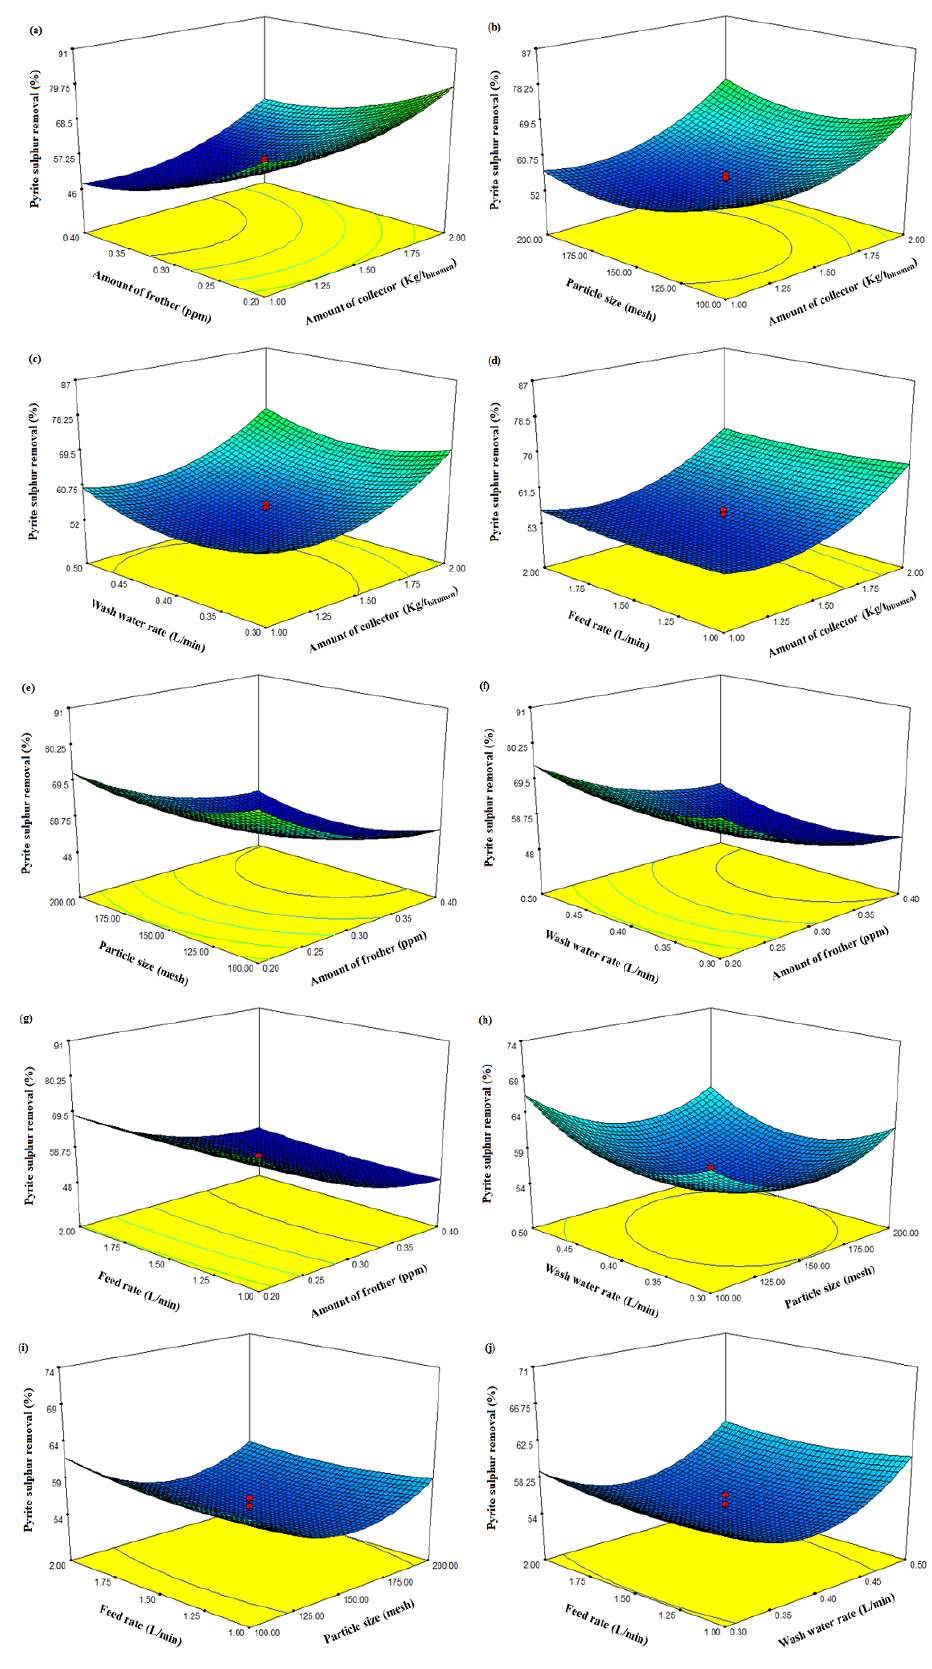
Fig. 5 . Response surface plot for pyrite sulphur removal